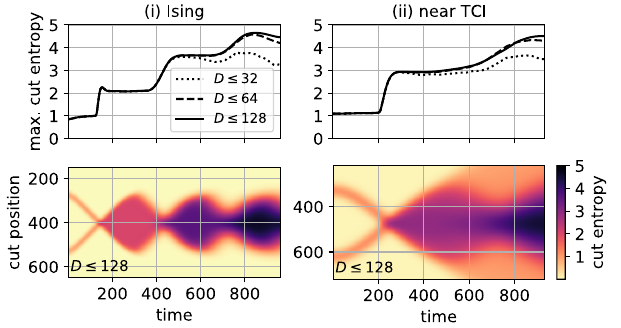
FIG. 11. Entanglement entropy (base 2) for cuts (left-right bipartitions) of the spin chain as a function of time for simula- tions (i) and (ii) of Fig. 7. Convergence with the bond dimension D slows as time goes on. For example, in (i) the maximum cut entropy at D ≤ 128 is very likely not converged after t ≈ 700.